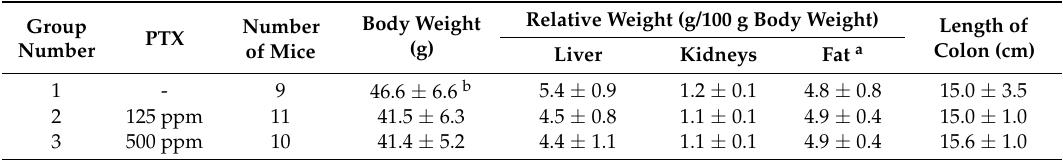
Table 1. General observations of the experimental